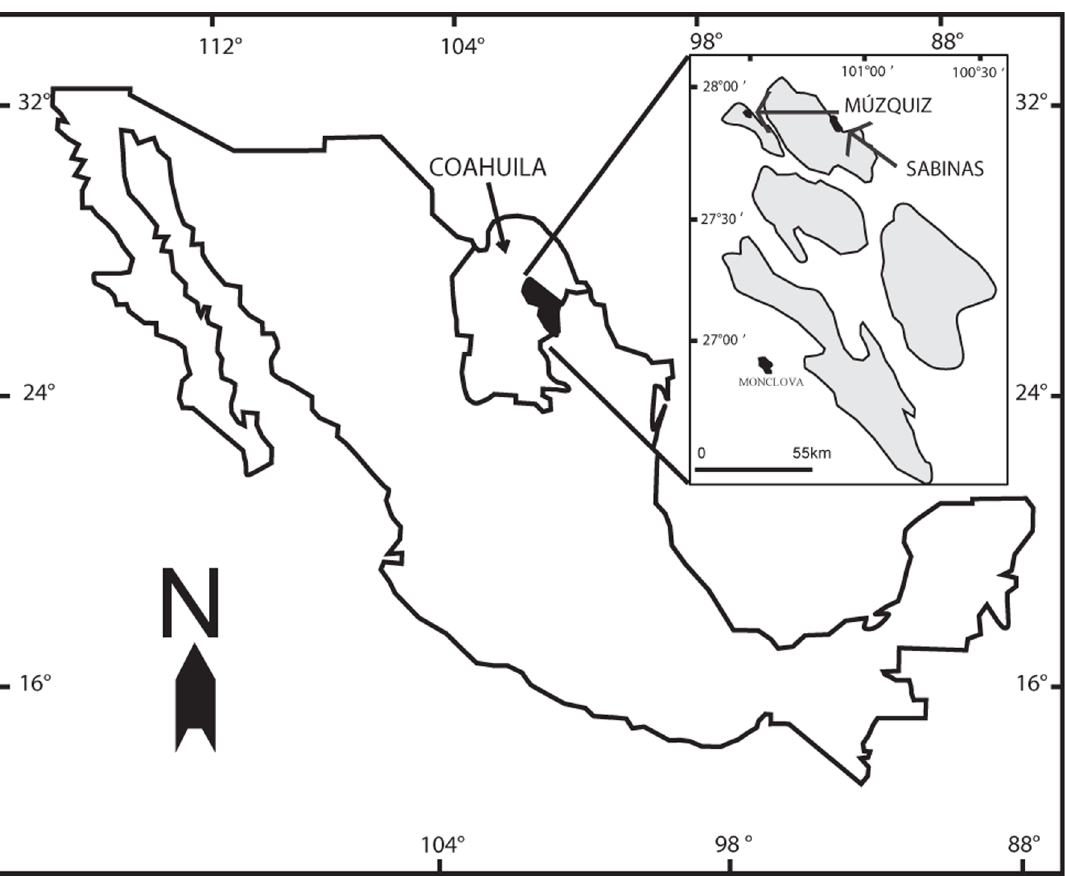
Figure 1. Location map of the Olmos Formation in the Sabinas Basin (in gray). Sampled sites in Sabinas and Mu´zquiz (Atascoso and Santa Elena Ranchs) are identified by